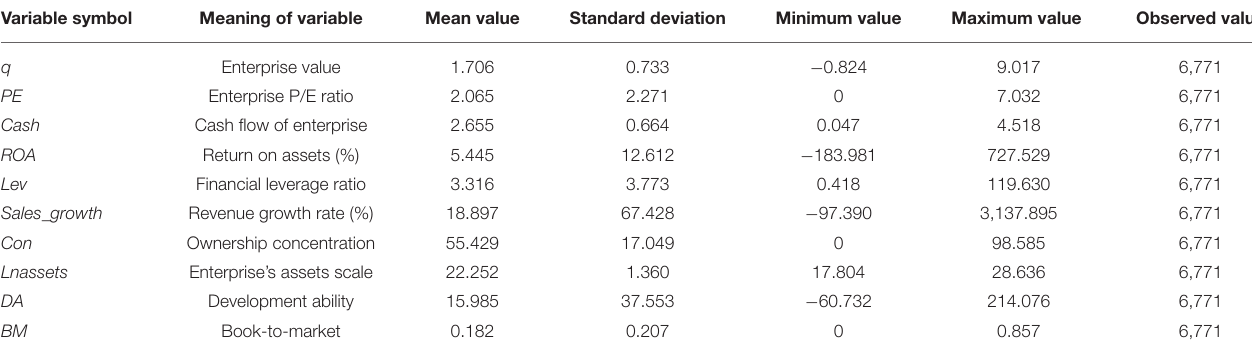
TABLE 1 | Descriptive statistics.